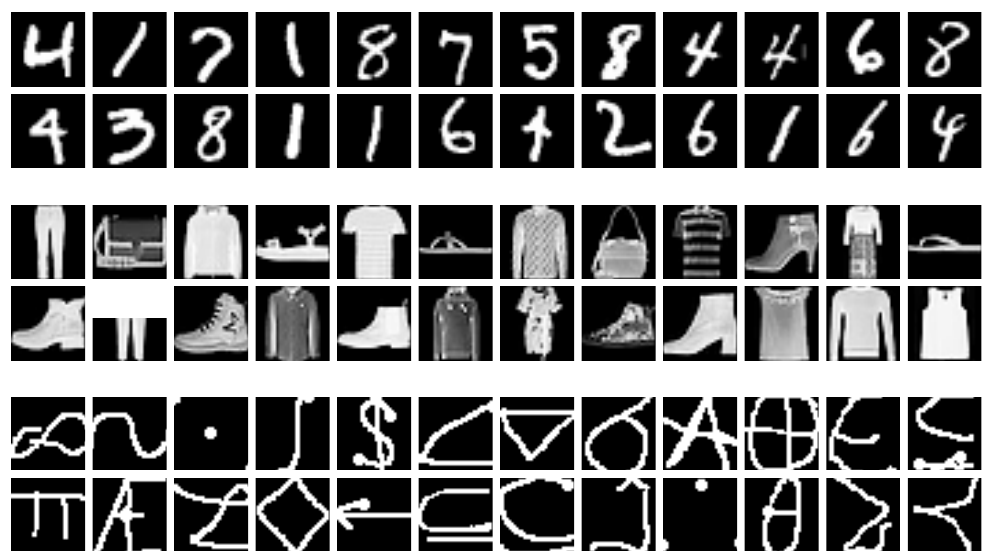
Figure 2. Samples of the datasets used in our experiments. Top: MNIST. Middle: Fashion MNIST. Bottom: HASYv2 (colors